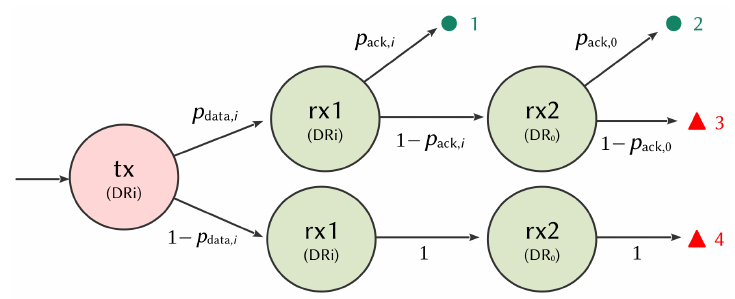
Figure 12. State chart of a LoRa node for one